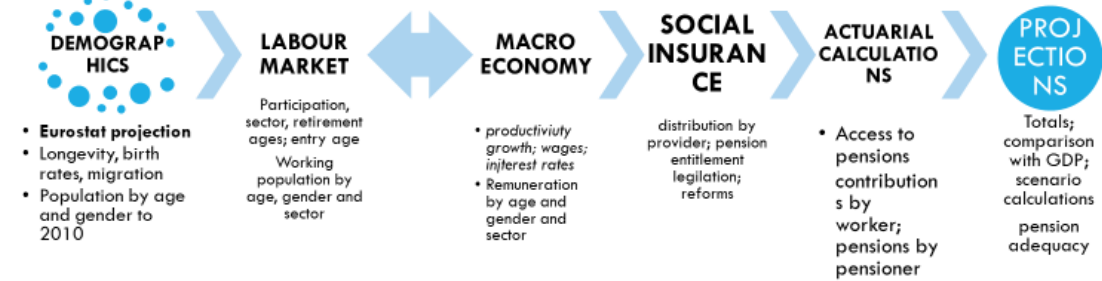
Figure 1. A schematic representation of AWG methodology.